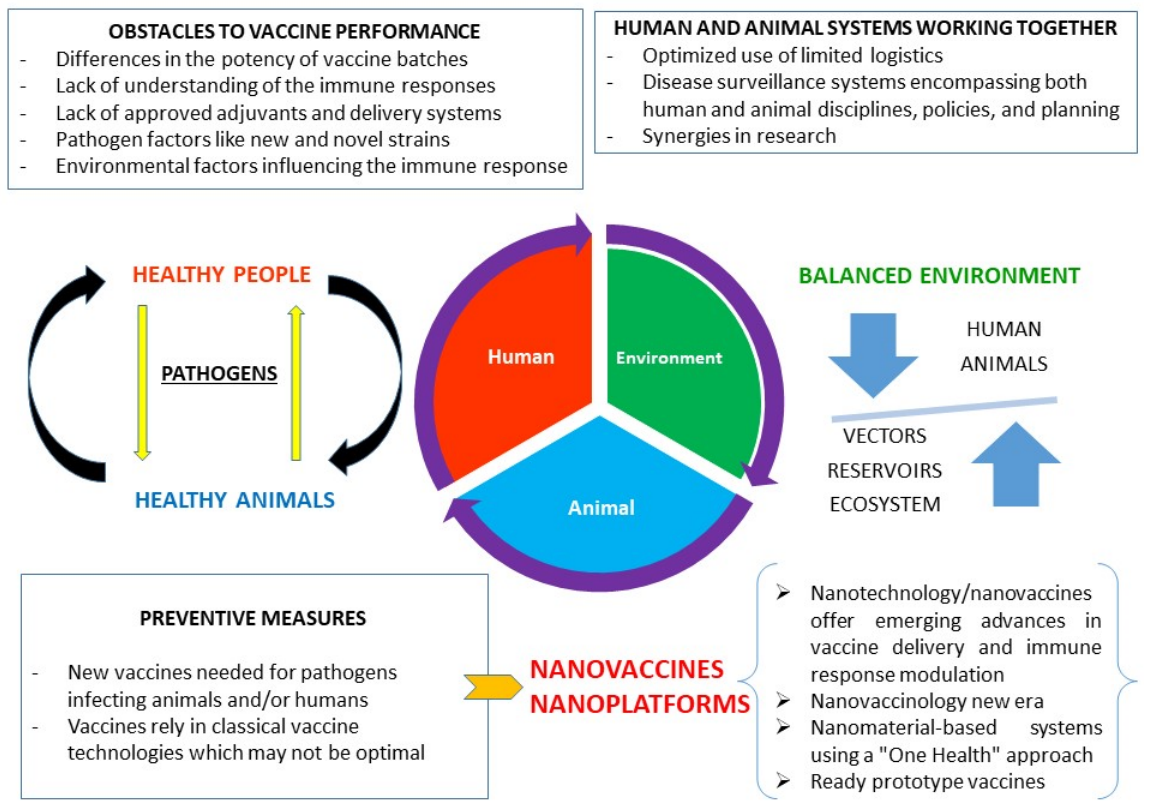
Figure 2. Nanovaccines as key elements regarding a One Health approach as preparation for future threats.